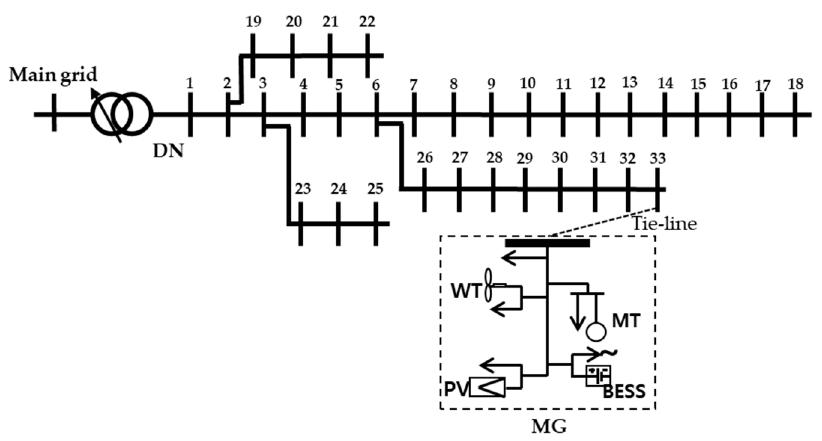
Figure 7. IEEE (Institute of Electrical and Electronics Engineers) test system.